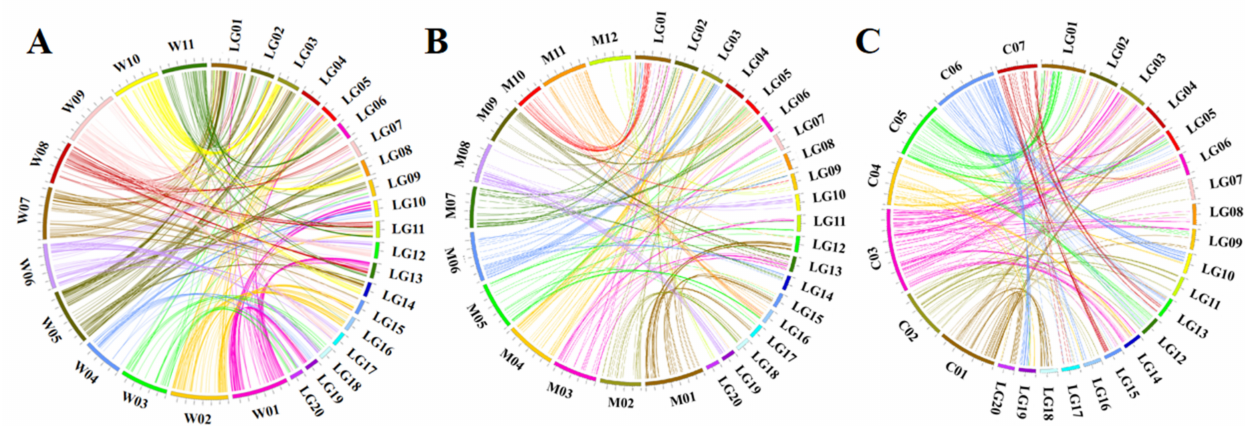
Figure 3. Syntenic relationships of C. pepo with ( A ) C. lanatus , ( B ) C. melo , and ( C ) C. sativus . Chromosome synteny between C. pepo and C. sativus was based on 391 cross-species markers; synteny between C. pepo and C. melo was based on 425 cross-species markers; synteny between C. pepo and C. lanatus was based on 717 cross-species markers. W1–W11 represent C. lanatus ’ eleven chromosomes, M01–M12 represent C. melo ’s twelve chromosomes, C01–C07 represent C. sativus ’s seven chromosomes, and LG01–LG20 represent C. pepo ’s twenty chromosomes. Syntenic blocks are connected by the same color lines from C. pepo chromosomes.